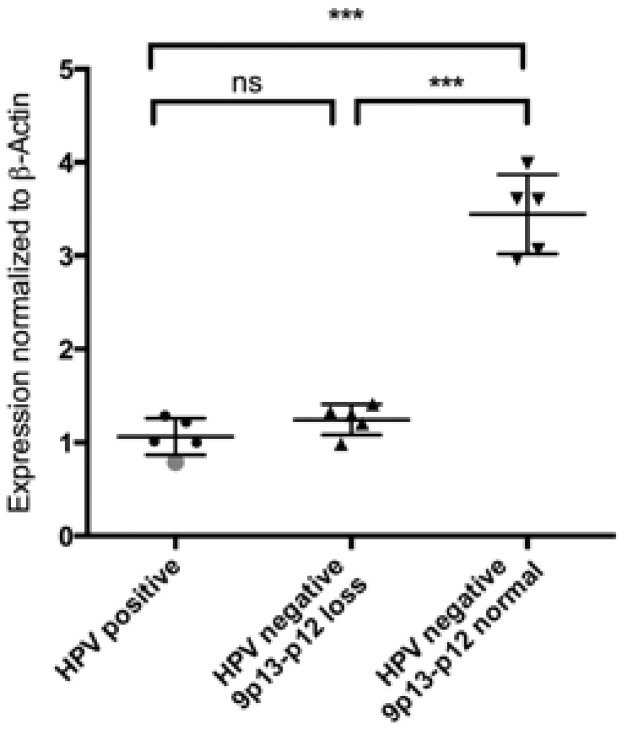
Expression of the VCP gene.qPCR has been performed on HPV-negative samples with known status of the 9p13-p12 region containing the VCP gene (5 samples each). Grey dot: HPV-positive sample with loss of 9p13-p12. HPV16-positive samples with no aberration of this locus were included for comparison (n = 5). Expression was normalized to β-Actin. *** p<0.001, Kruskal-Wallis test.